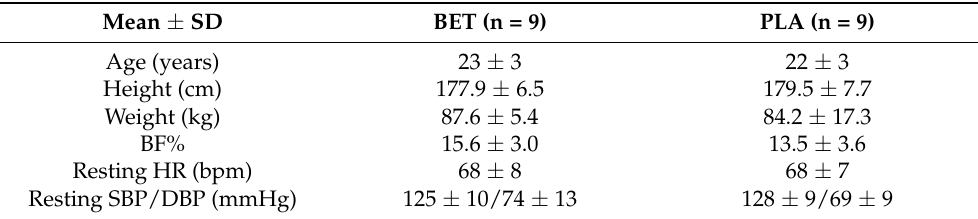
Table 1. Participant demographics, anthropometrics, and resting hemodynamic